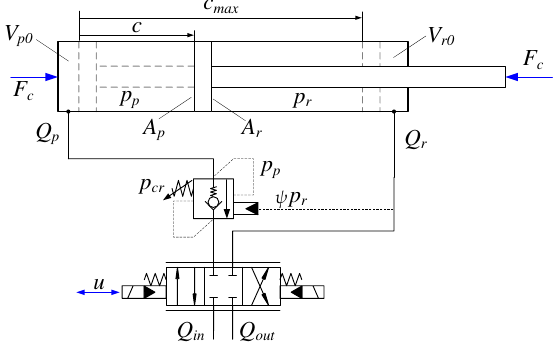
Figure 8: Simplified hydraulic circuit; cylinder, over- center valve and directional control